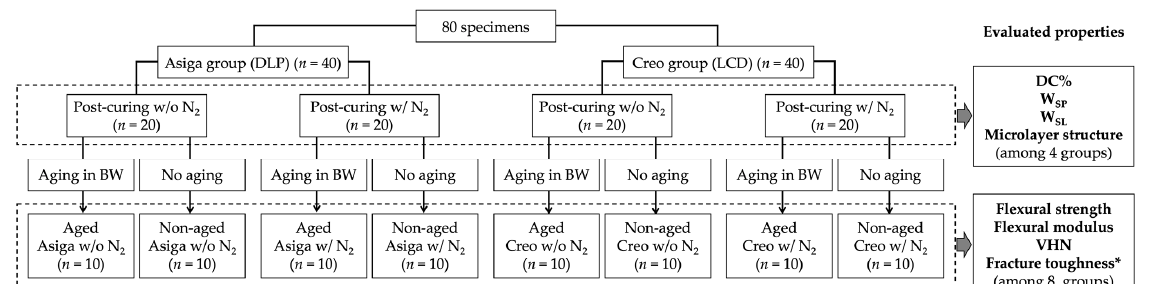
Figure 2. Flowchart of specimen fabrication. DLP: digital light processing; LCP: liquid crystal display; N 2 : nitrogen gas; BW: boiling water; DC%: degree of double bond conversion; WSP: water sorption; WSL: water solubility; and VHN: Vickers hardness number; Post-curing w/o N 2 : stroboscopic